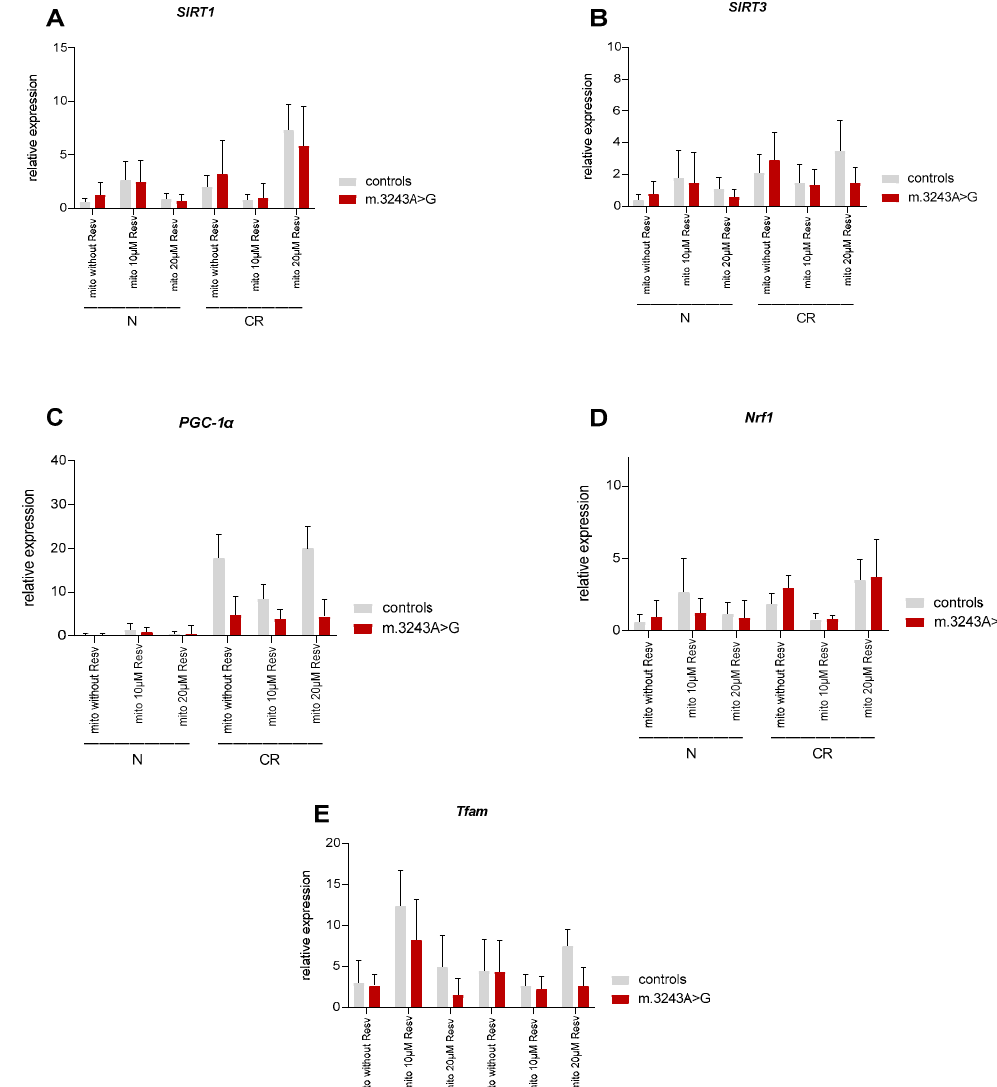
Figure 3. Evaluation of gene expression in myoblasts from patients (n = 5) and controls (n = 5), analyzed as previously described. ( A ) SIRT1 , ( B ) SIRT3 , ( C ) PGC-1 α , ( D ) Nrf1 , and ( E ) Tfam after 48 h, N vs. R conditions. The significant differences are shown in Tables 5 and 6, and Table S2.